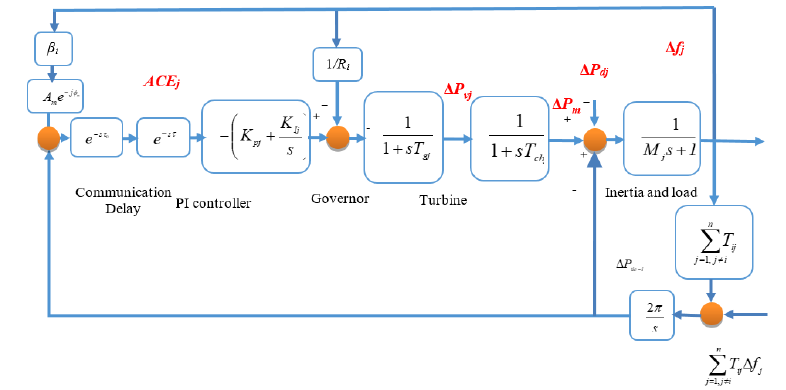
Figure 2. The dynamic model of multi-area LFC with phase and gain